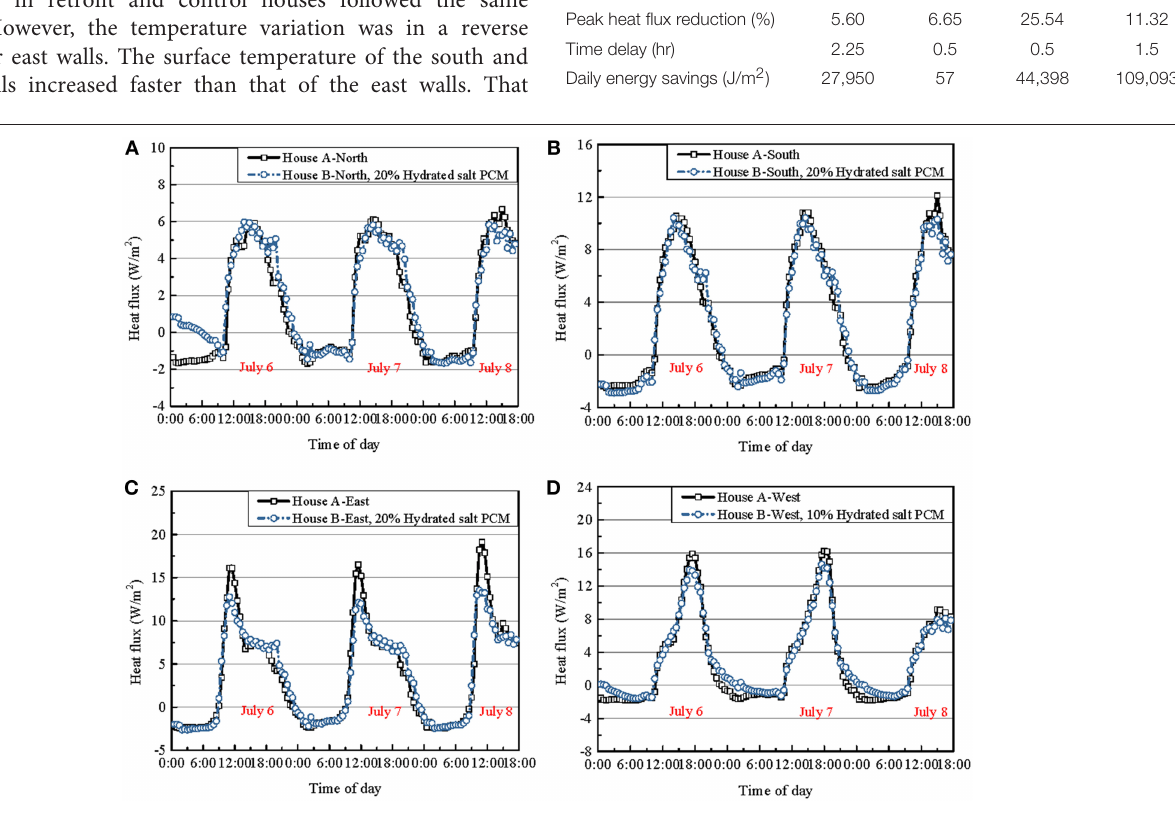
Frontiers in Energy Research |